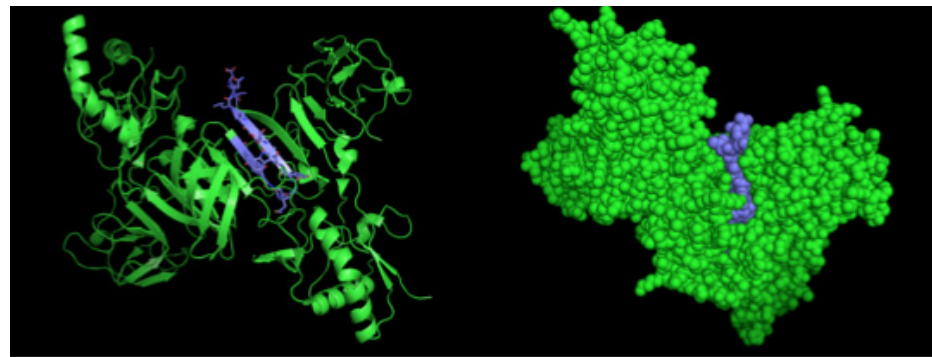
Figure 5. Three ‐ dimensional structural model of a NS1 dimer and regions corresponding to epitopes recognized by 2H5 and 4H1BC mAbs. The NS1 3D model was generated by the program PyMOL in green. The sequence 193 AVHADMGYWIESALNDT 209 is highlighted in blue.